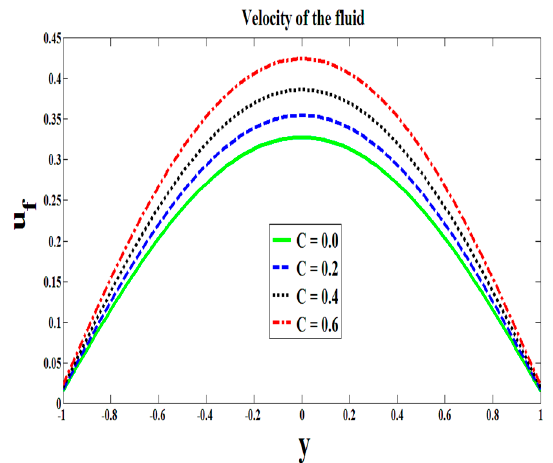
Figure 4. E ff ects of C on the